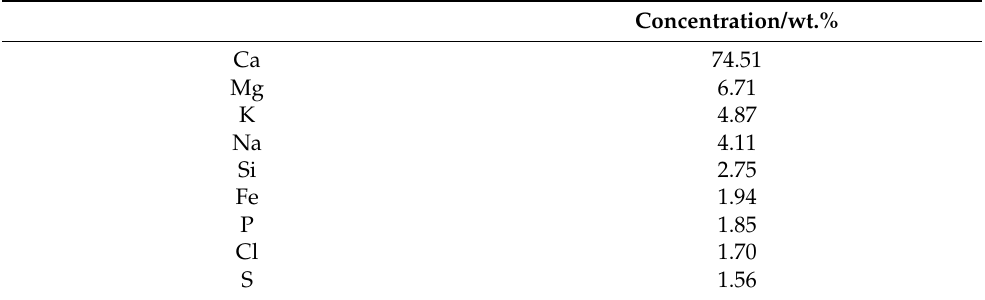
Table 3. Percentage of elements in pine tree biochar estimated from XRF measurement (C is removed from the